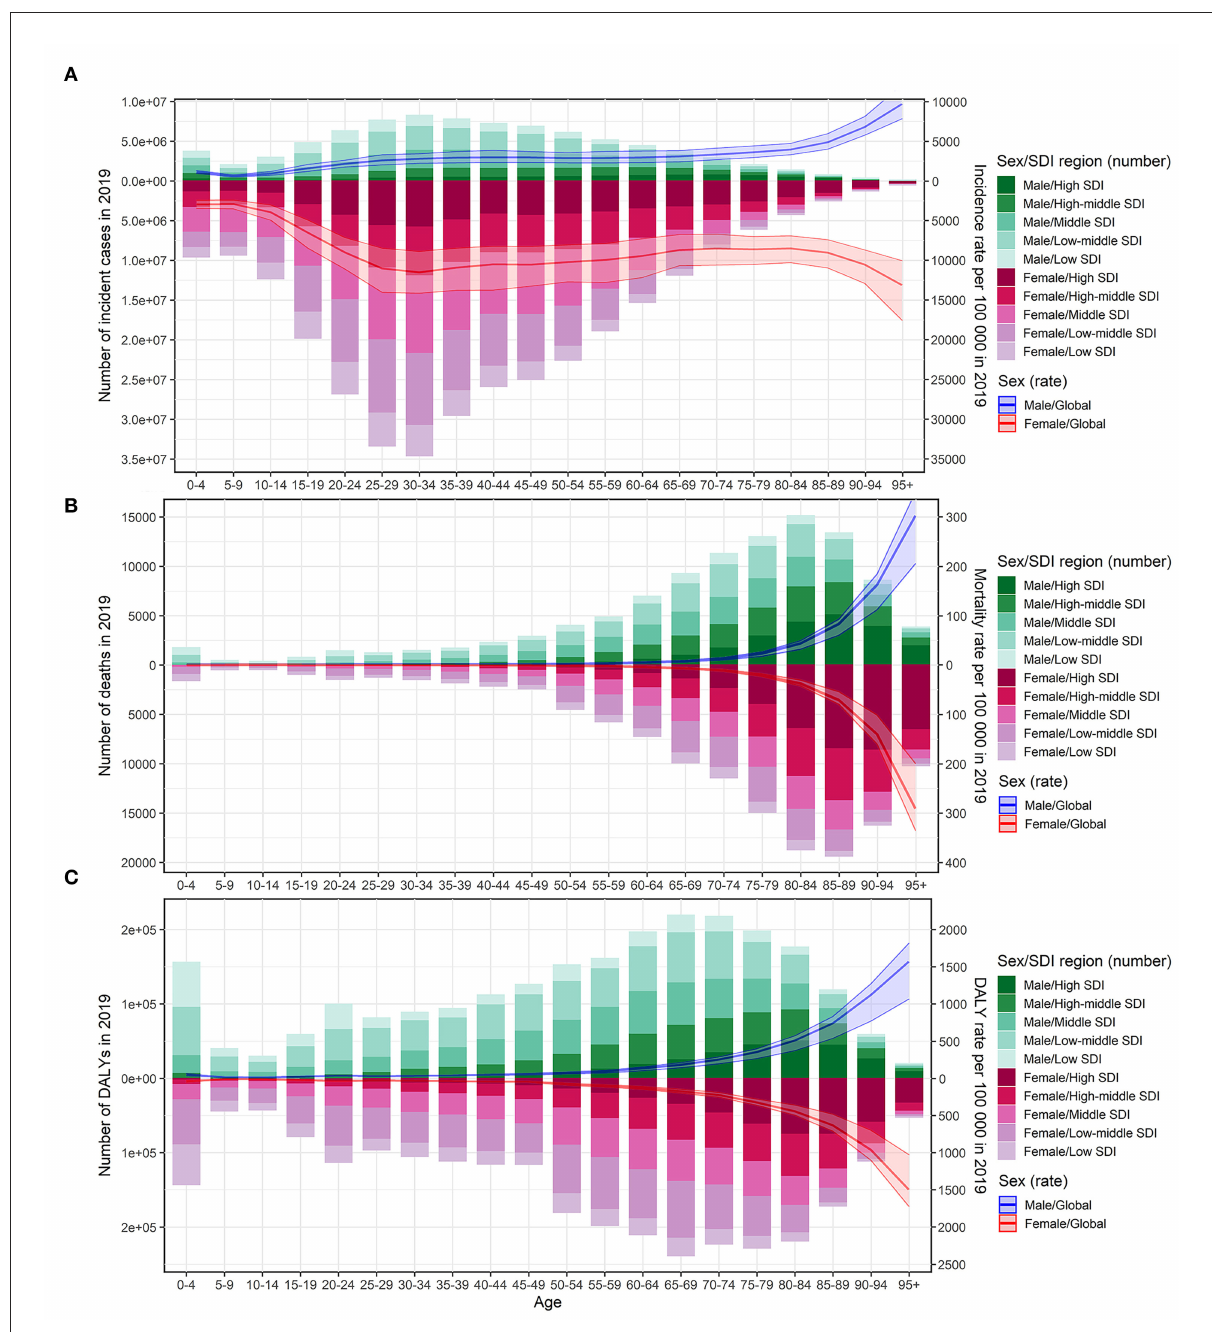
FIGURE3 Age-specific number of cases and burden of urinary tract infection according to sex in 2019. The bar plot presented the absolute burden of urinary tract infection, and the line plot presented the age-specific burden rate of urinary tract infection. (A) Incidence of urinary tract infection. (B) Mortality associated with urinary tract infection. (C) DALYs associated with urinary tract infection. DALYs, disability-adjusted life years; SDI, socio-demographic index.